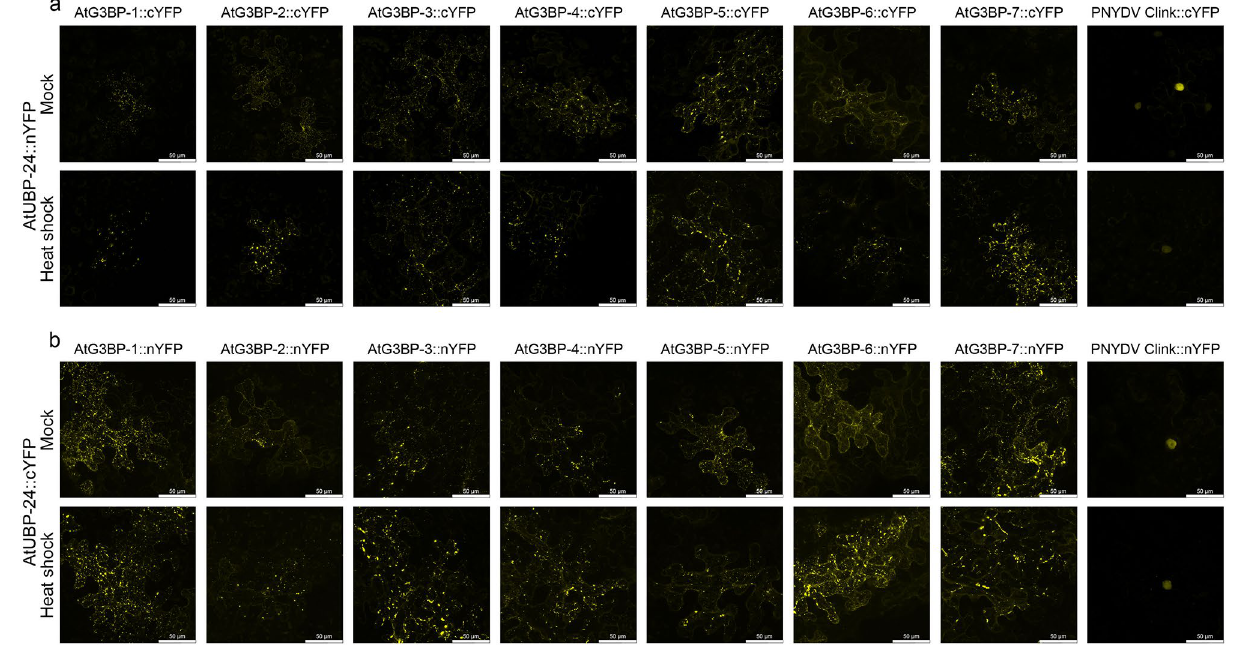
Figure 4. Visualization of protein–protein interaction of the AtUBP-24 with the various AtG3BPs and PNYDV Clink via bimolecular fluorescence complementation (BiFC) under ambient conditions and heat shock (45 min at 37 °C). ( a ) Interaction of AtUBP-24 with the corresponding partners fused C-terminally with splitYFP. ( b ) Interaction of AtUBP-24 and the respective AtG3BPs and PNYDV Clink N-terminally fused to splitYFP. All pictures are projections of z-stacks obtained by confocal laser scanning microscopy. The individual pictures correspond to a size of 185 × 185 µm.